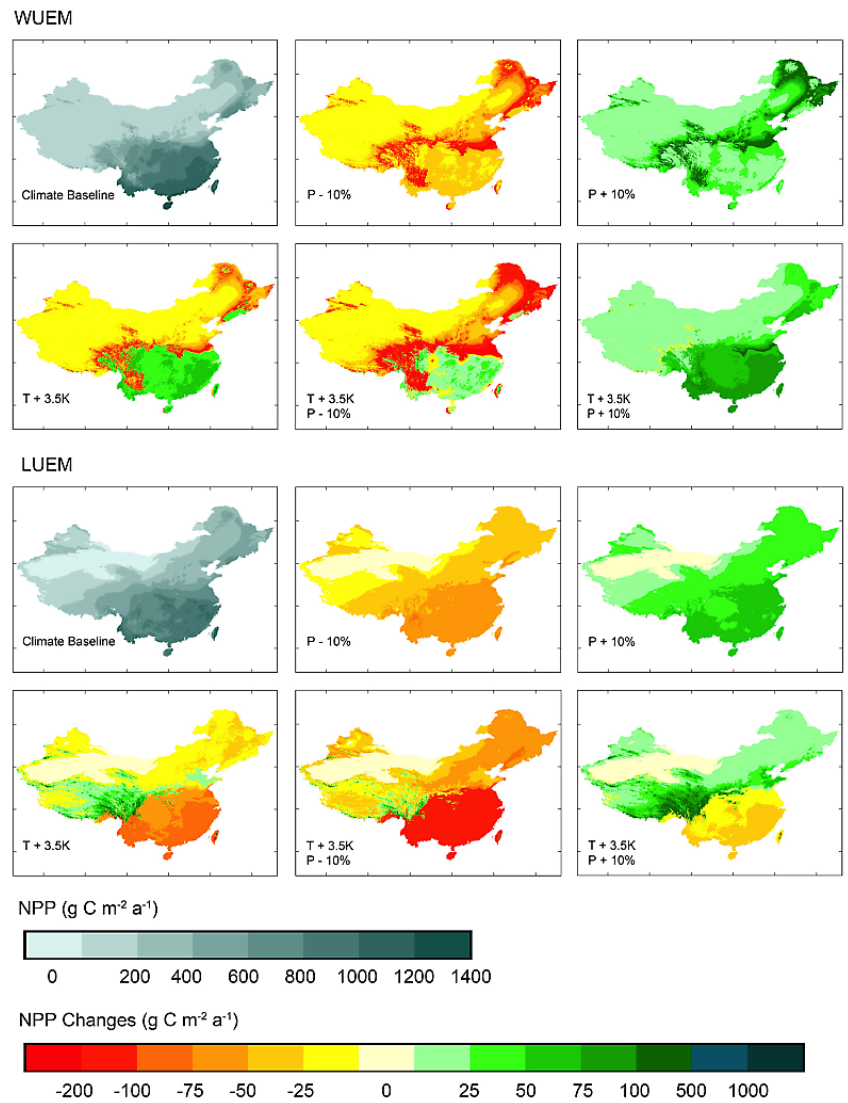
Fig. 4. The distribution pattern of NPP and NPP changes predicted by WUE model and LUE model, in six climatic scenarios under recent [CO 2